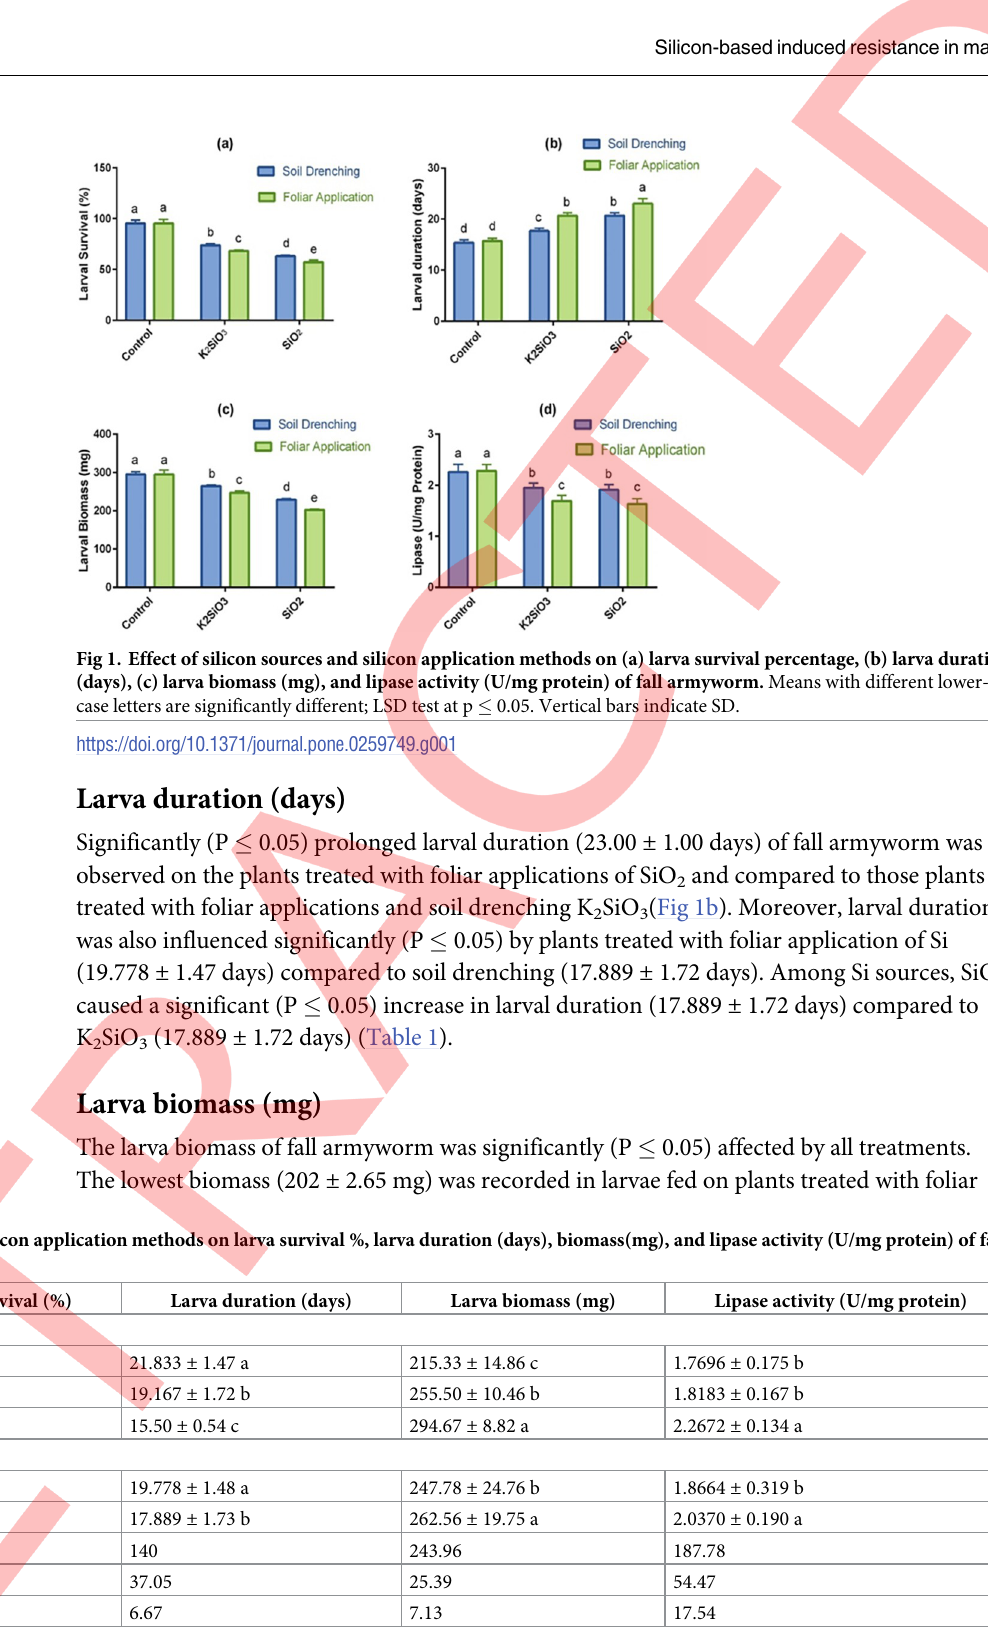
Means within a column followed by different lower-case letters are significantly different at P � 0.05 (LSD